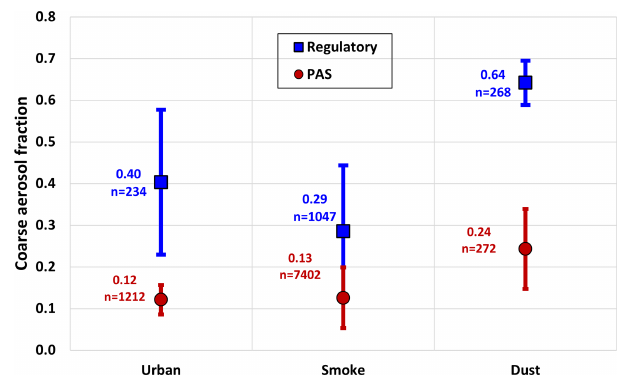
Figure 3. Mean coarse aerosol fraction (CAF) (Eq. 3) calculated us- ing the regulatory data and the PAS raw (CF = 1) data for 17 events from the Part I dataset that had both PM 2 . 5 and PM 10 . The values near each point give the mean and number of data points (hours) in each bin.